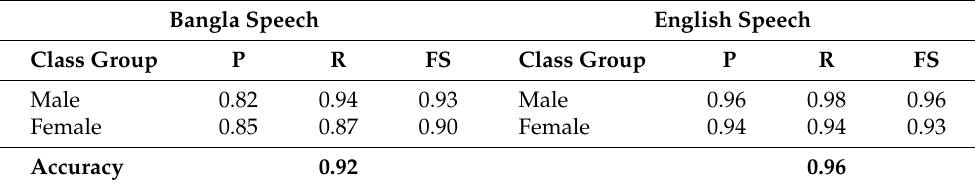
Figure 9. Confusion matrices of Gender for Bangla and English Speech. Table 7. Classification Results of Gender for Bangla and English Speech precision (P), recall (R), f1-score (FS) using the SCAE-MLELMs